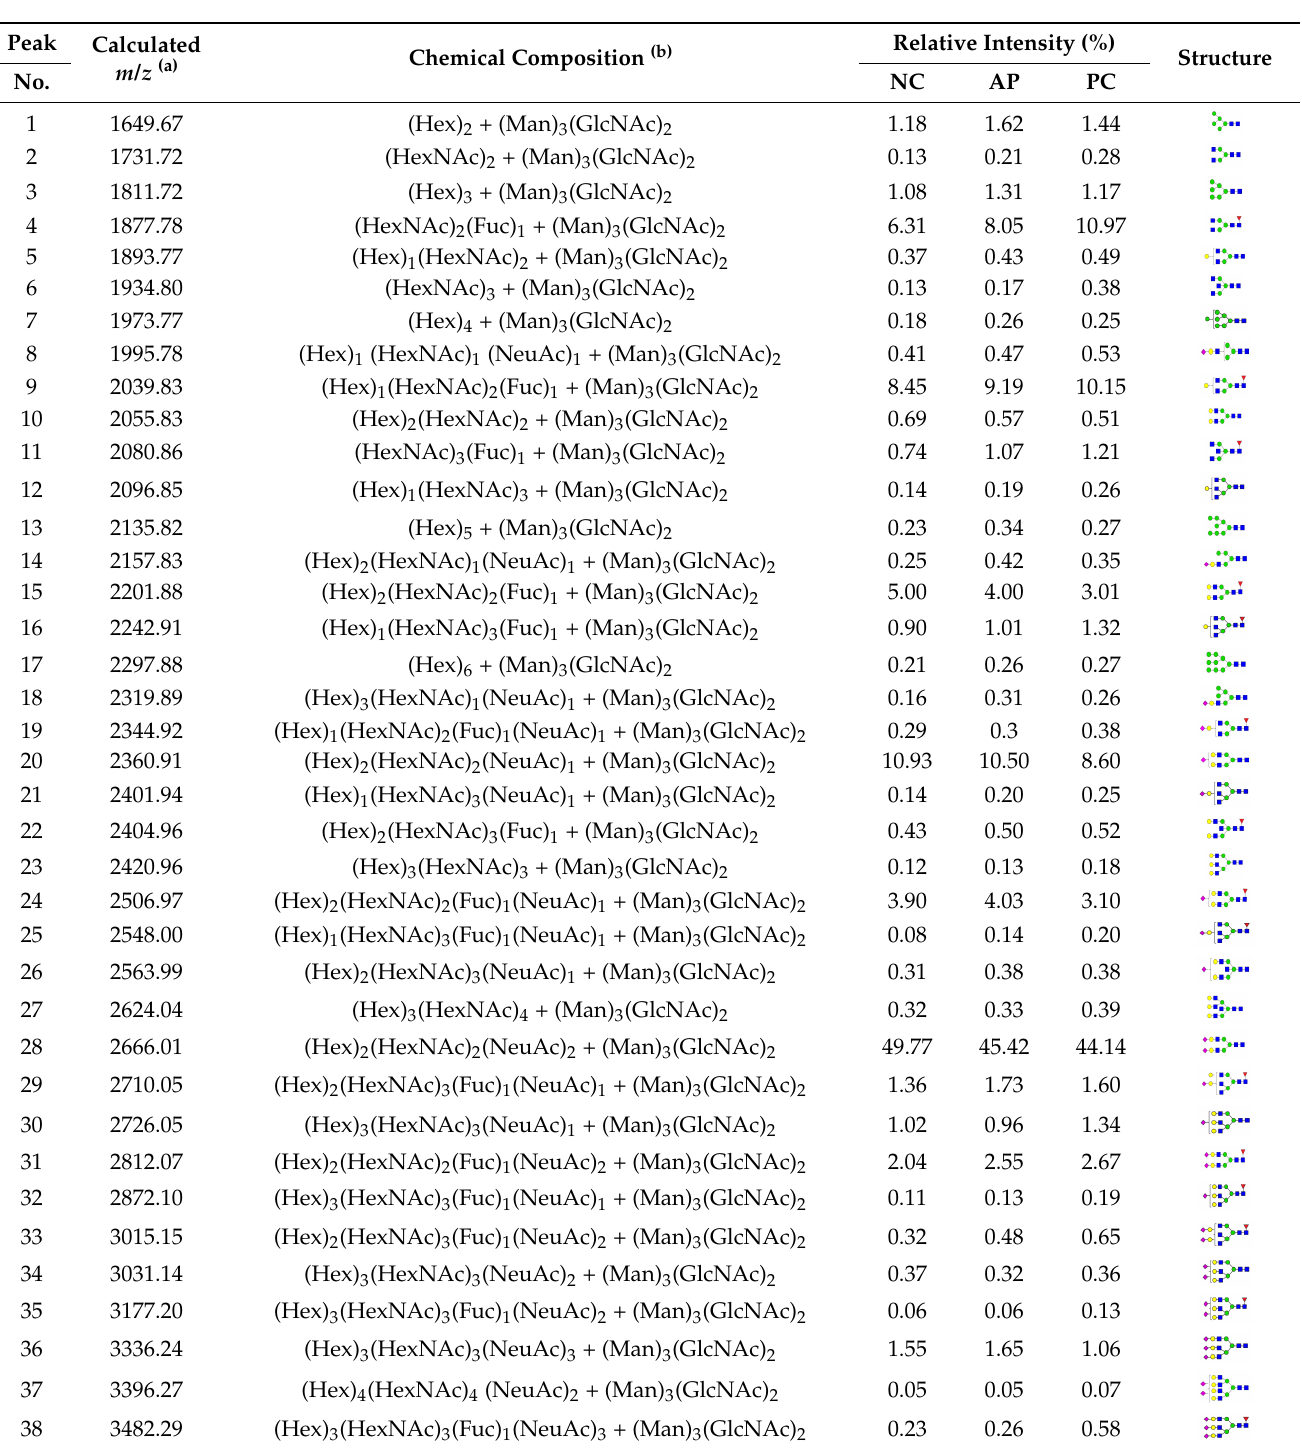
Table 1. Summary of N -linked glycans released from the sera of NC individuals and AP and PC patients and identified by MALDI-TOF